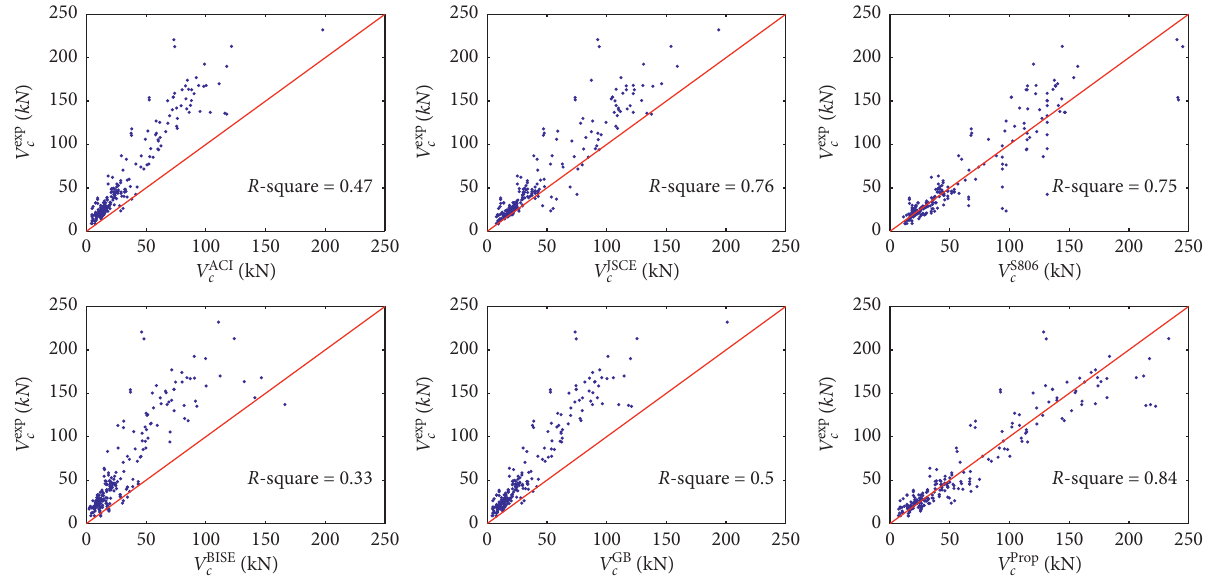
Figure 8: Comparison of V pred Table 3: Mean, SD, and COV for ratio of ( V exp